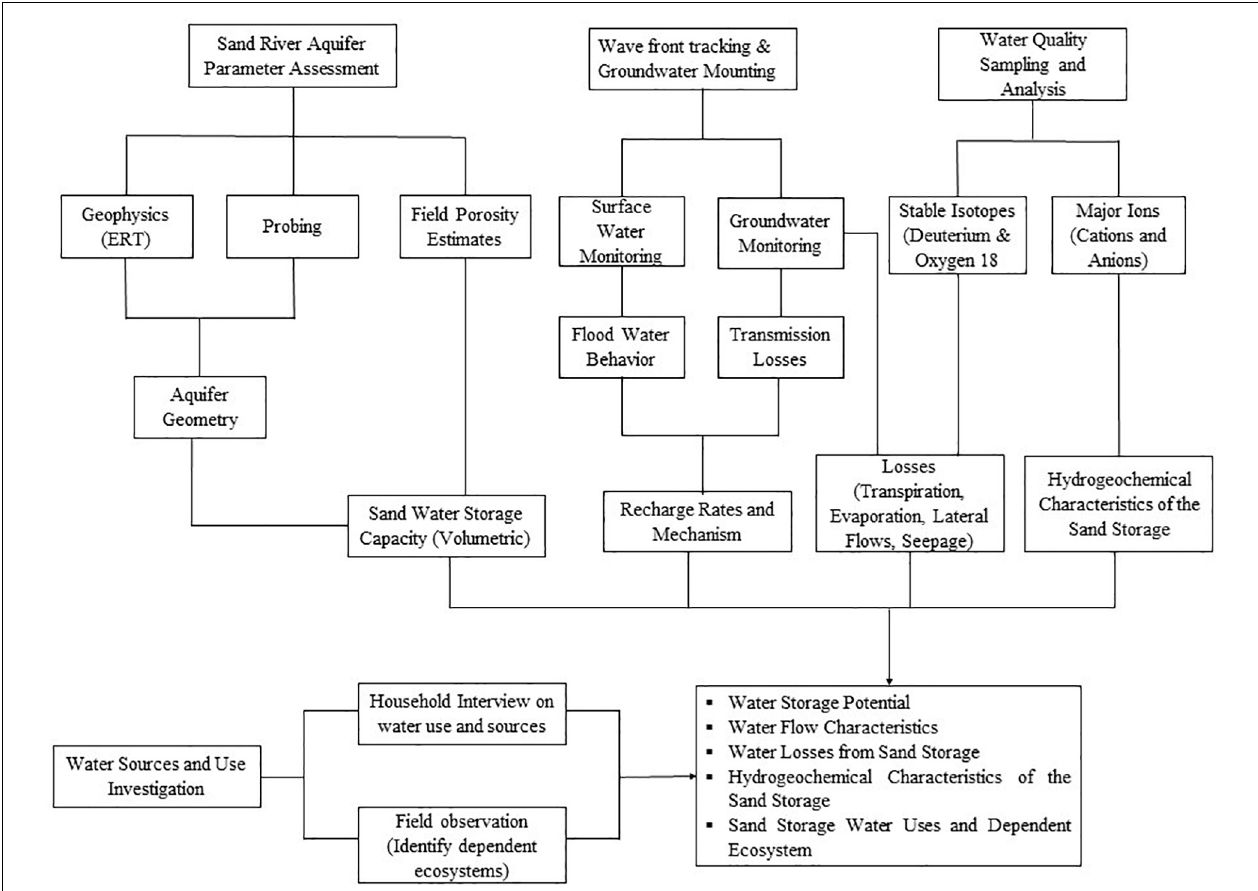
FIGURE 1 | Conceptual approach of the study: flow of methodologies. A three-step multi-method approach was adopted: (1) Desktop study and data collection planning; (2) Field investigations; and (3) Data processing and analysis. Applied techniques cut across the three main group of techniques available to study ephemeral rivers (Shanafield and Cook,